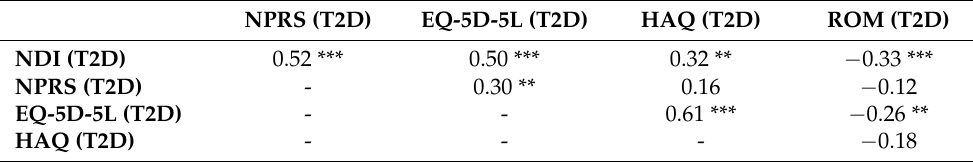
Table 4. Correlations of PROMs and ROM for performance scores (T2D).